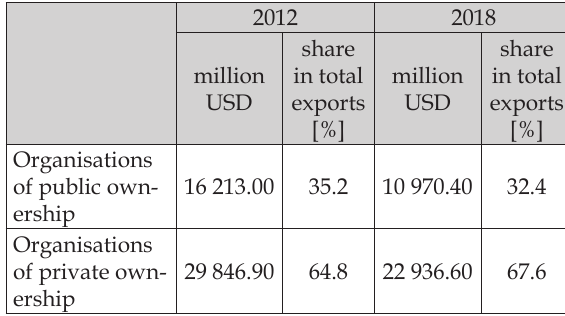
Table 3. Goods exports by organisations of different ownership of the Republic of